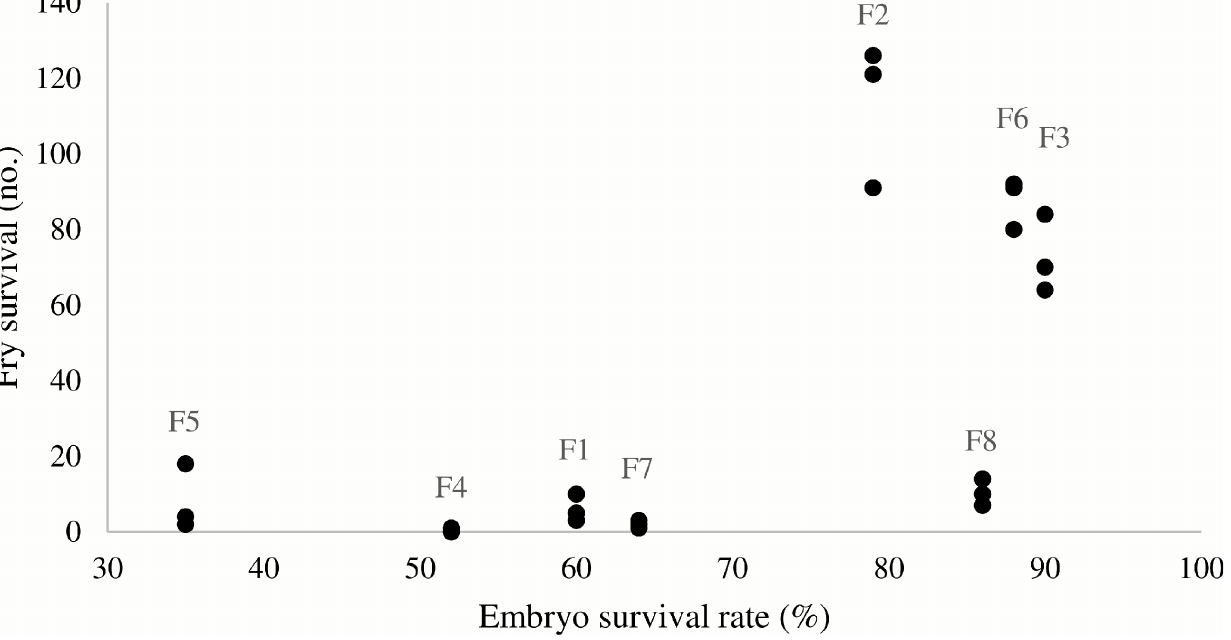
Fig 2. Scatterplot of survival in the fry stage versus survival in the embryo stage. For each observation of embryo survival, there are three replicate observations of fry survival. Labels above indicate batch